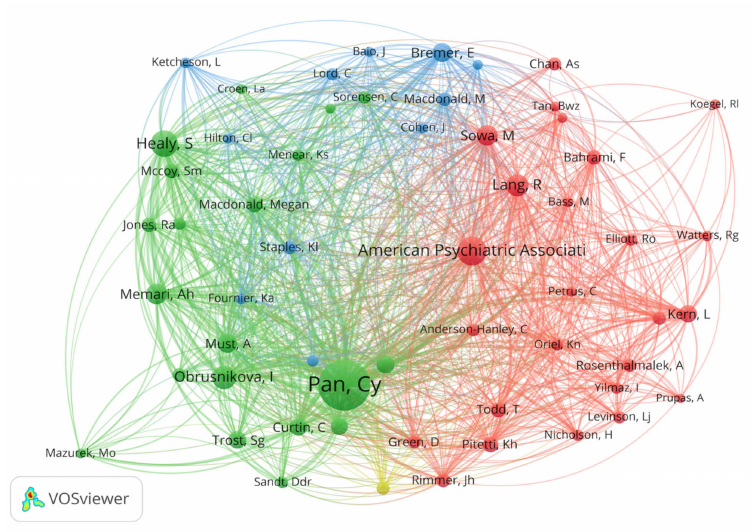
Figure 8. The author’s co-citation network regarding PA research on